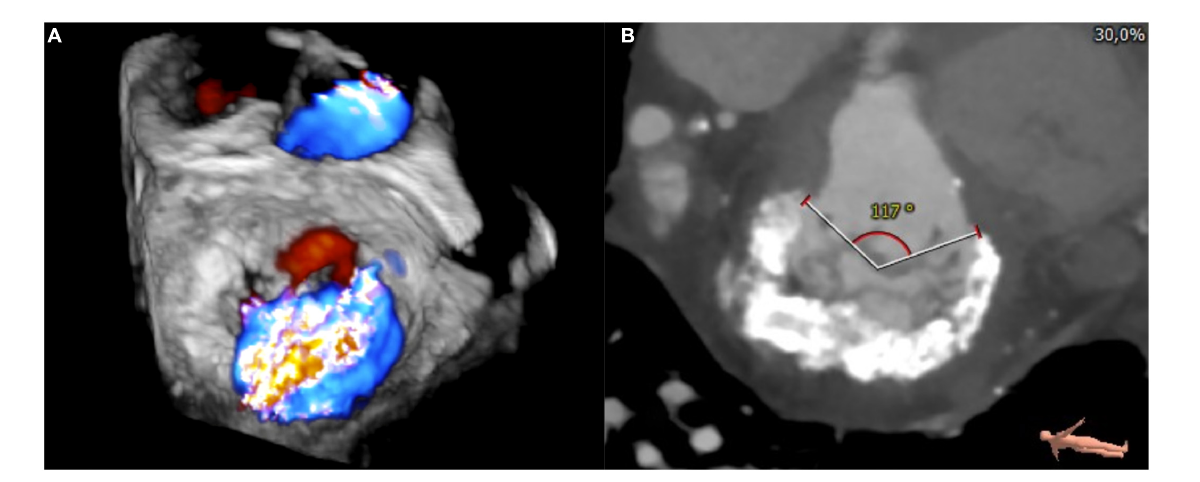
FIGURE1 3D transesophageal echocardiography (A) and cardiac computed tomography (CT)-scan (B) showing severe mitral annular calcification (MAC) and coexisting severe mitral regurgitation.